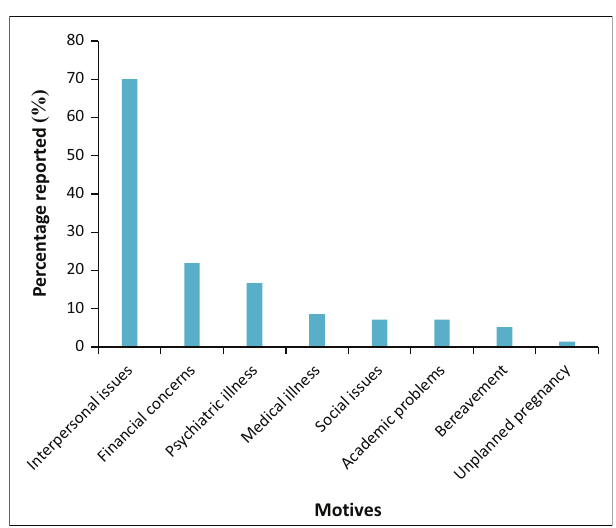
FIGURE 1: Percentage of reported motives for deliberate